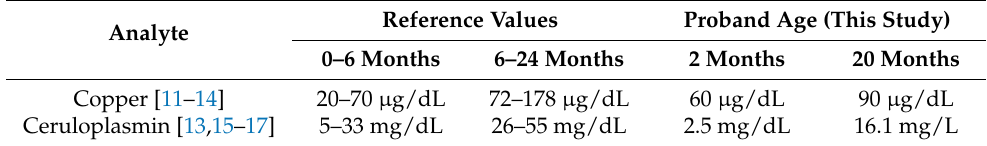
Table 2. Age-adjusted copper and ceruloplasmin